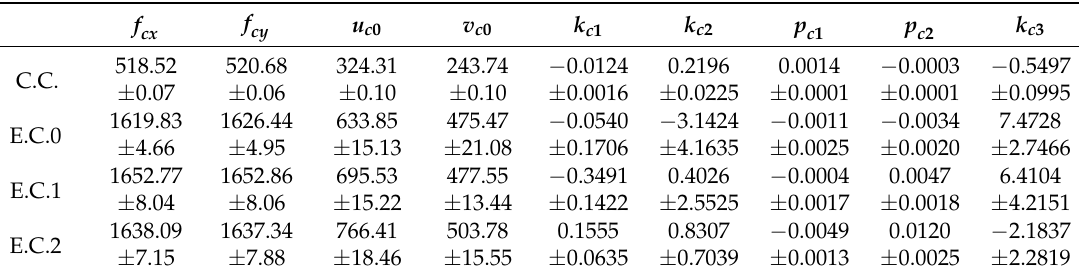
Table 2. Color camera intrinsic parameters.